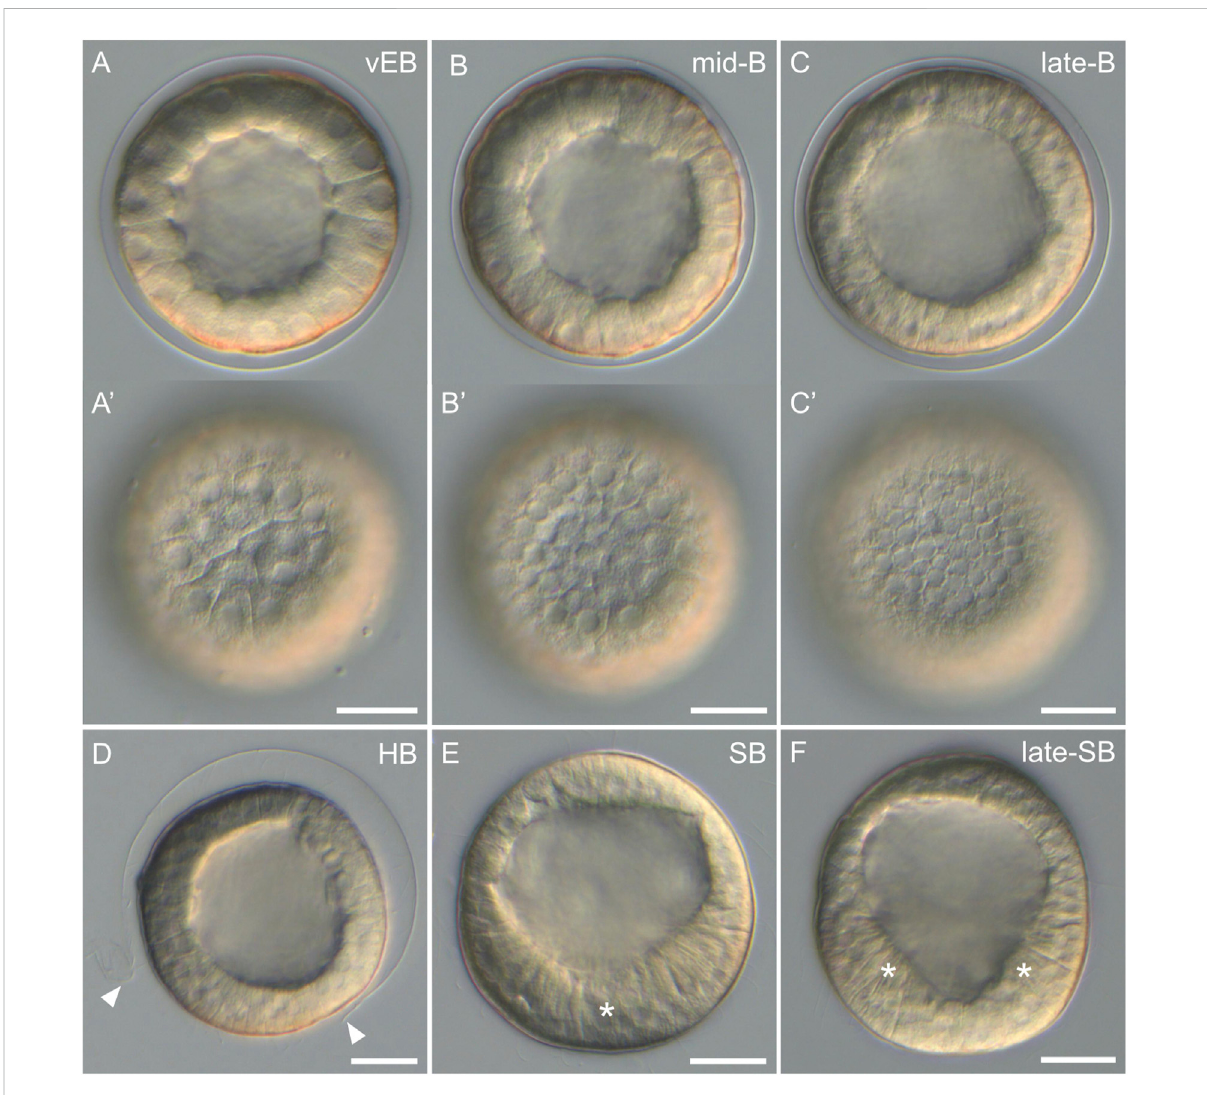
FIGURE 5 Blastula stages of Paracentrotus lividus under lightmicroscopy.Developmental stages are as follows: (A,A ’ ) very early blastula stage (vEB); (B,B ’ ) mid-blastula stage (mid-B); (C,C ’ ) late blastula stage (late-B); (D) hatched blastula stage (HB); (E) swimming blastula stage (SB); (F) late swimming blastula stage (late-SB). In (A – F) , the embryos are in lateral view with theanimal pole up. (A ’ ,B ’ ,C 9 ) are optical surface views of, respectively, (A – C) . In (D) , arrowheads mark the rupture of the fertilization envelope. In (E) , the asterisk indicates the thickening of the cells constituting the vegetal plate, at the vegetal pole. In (F) , asterisks highlight the “ V ” shape of the vegetal plate. Scale bar: (A – F) 30